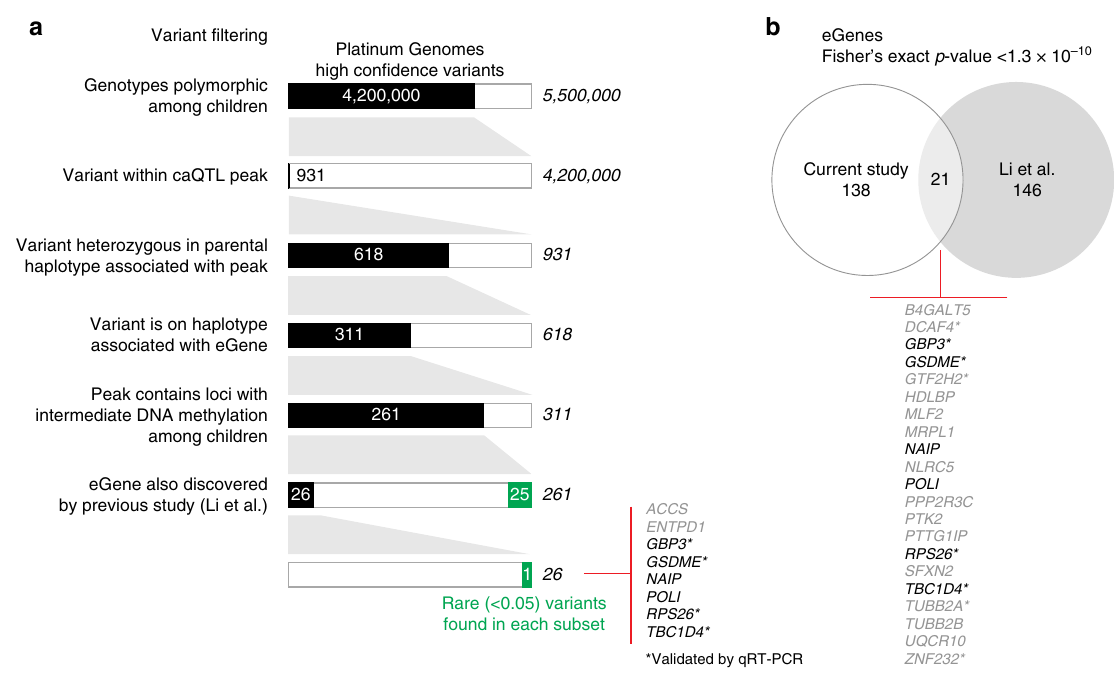
Fig. 1 Identi fi cation of high-con fi dence multifunctional variants. In a we show the steps involved in proceeding from 5.5 million high-con fi dence variants in this family to the 26 likely to have effects on gene expression, chromatin accessibility, and DNA methylation. An ATAC-seq peak for which the number of reads is in fl uenced by a speci fi c parental haplotype was required to include a polymorphic sequence within the peak, a polymorphism for which that parent had to be heterozygous. We then further fi ltered by requiring the locus to have an intermediate DNA methylation value, consistent with only one allele being active, and then fi ltered to overlap with the eGenes that we found to be in common with Li et al. 46 This list is shown in b with those validated by qRT- PCR marked with an asterisk, and those genes in common to ( a ) and ( b ) shown in black. We proceeded with TBC1D4 for further